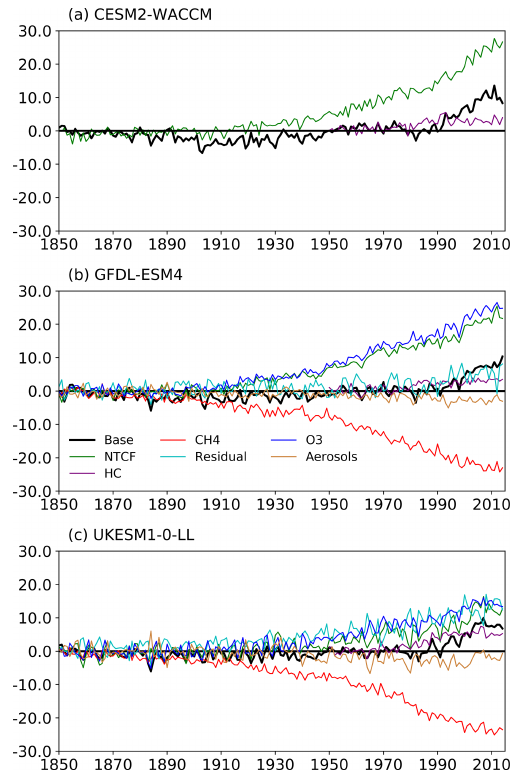
Figure 5. The histSST (base, in black) tropospheric OH anomaly (percent change relative to PI) for each year (see Eq. 3) for the three models: (a) CESM2-WACCM, (b) GFDL-ESM4, and (c) UKESM1-0-LL. The coloured lines represent the contributions to this OH anomaly due to changes since 1850 in CH 4 mole frac- tion, NTCF emissions, halocarbon mole fraction, O 3 precursor emissions, and aerosols (see Eqs. 4–8; only NTCF and HC exper- iments from CESM2-WACCM). The residual curve (see Eq. 9) is the extra contribution required after linearly adding the curves for CH 4 , NTCF, and HC that is needed to reproduce the base